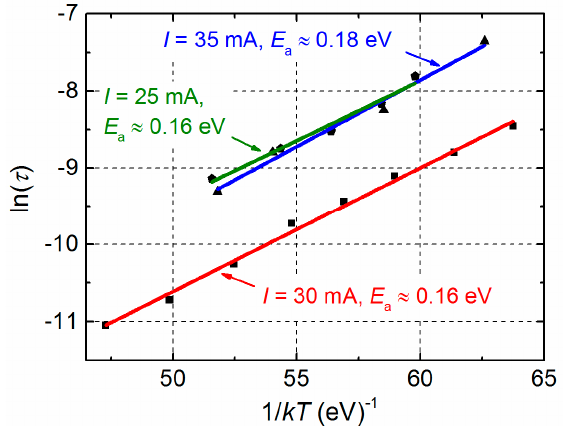
Figure 12. Dependencies of the relaxation time on the inverse temperature of different group A samples. The evaluated activation energies E a and experimental conditions are presented near the curves (square symbols denote ln ( τ ) values obtained from LD electrical noise spectra presented in Figure 11a).